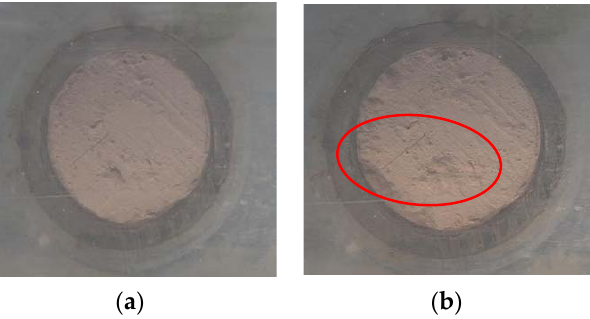
Figure 7. Incipient motion of sporadic sheet or block cohesive granular aggregates. ( a ) Primitive ( b ) Denudation of sheet or block cohesive granular aggregates.